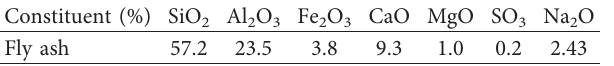
Table 1: Chemical Composition (%) of Fly